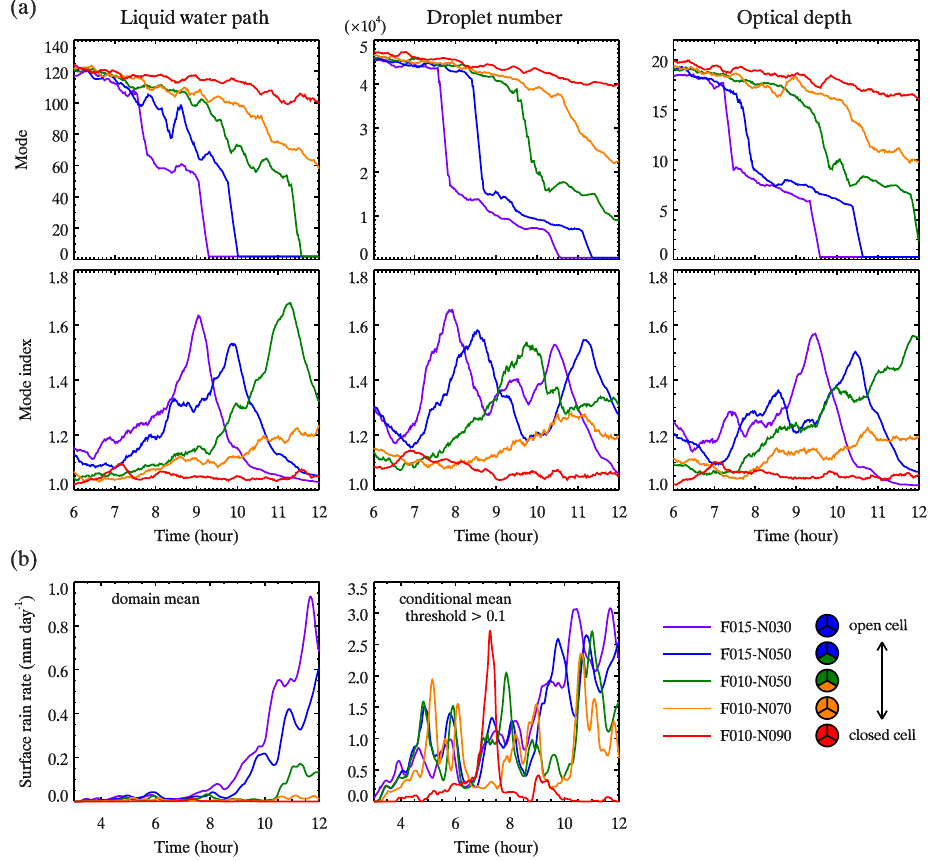
Figure 8. Time series for S2 simulations: (a) mode and mode index for LWP (g m − 2 ), N d (mm − 2 ) and τ from 6 to 12h and (b) domain mean and conditional mean (grid with > 0 . 1mmday − 1 ) of surface rain rate for the selected cases. A 15min running mean is applied. For reference, N d = 1 × 10 4 mm − 2 is equivalent to a local concentration of 50cm − 3 for a cloud depth of